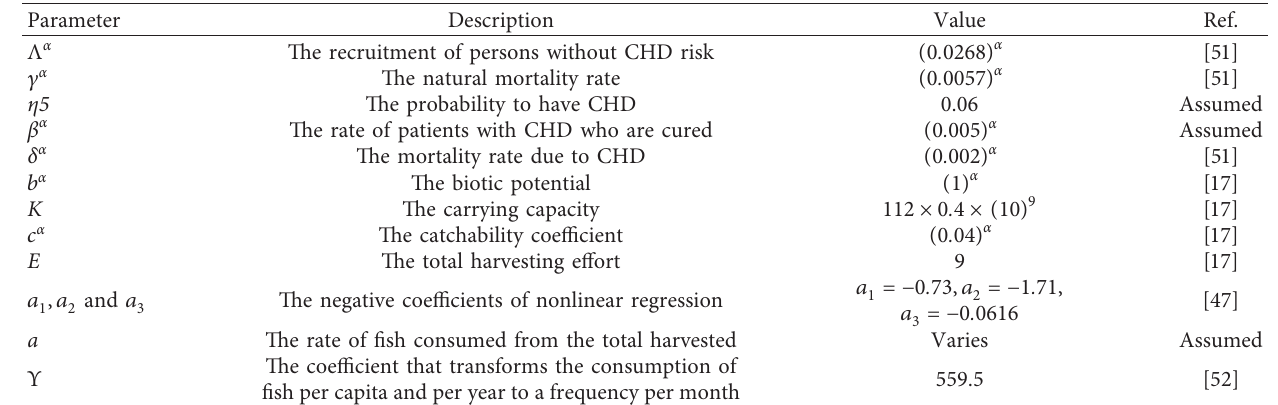
Table 1: Meaning and values of the parameters in system (1).